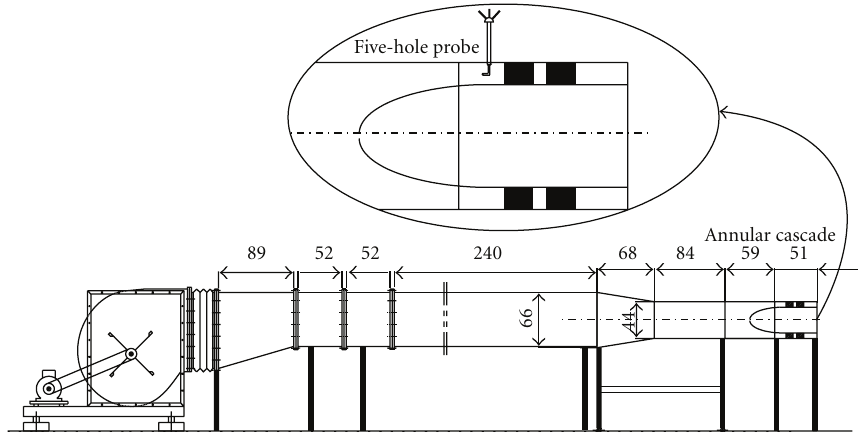
Figure 3: Experimental set-up.